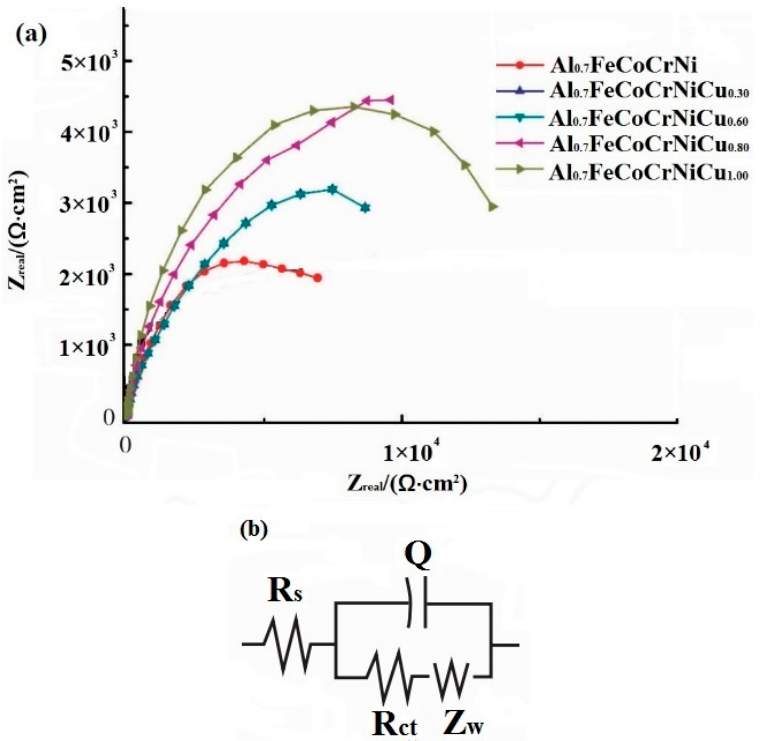
Figure 7. Nyquist plot ( a ) and equivalent circuit ( b ) of the Al 0.7 FeCoCrNiCu x high-entropy alloy in 3.5 wt.% NaCl solution.